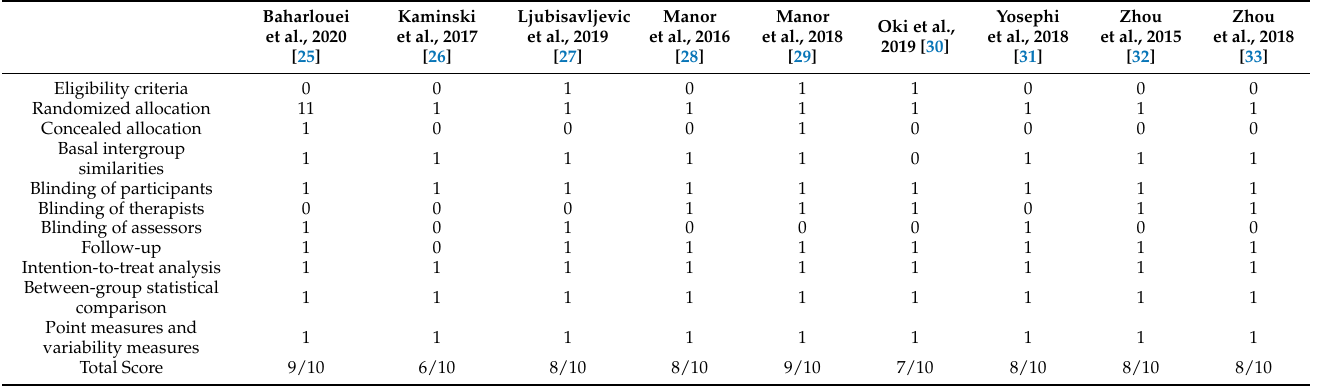
Table 1. Methodological quality of included articles in accordance with the PEDro